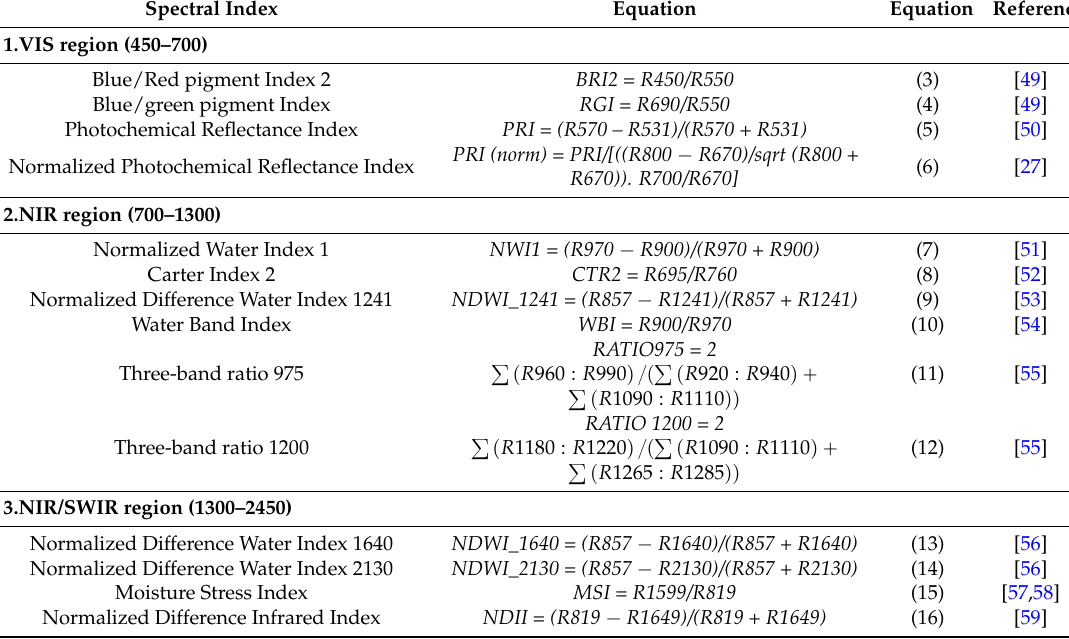
Table 1. List of the widely used water stress-related vegetation indices reviewed from the literature and used throughout this study. Rxxx indicates the reflectance at a specific